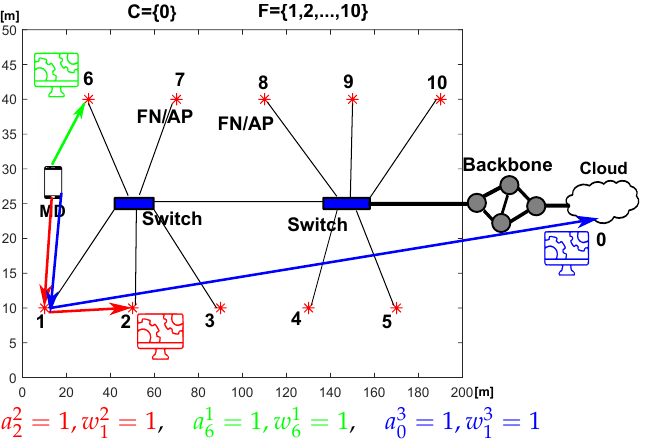
Figure 2. Diagram of the considered network composed of 10 FNs and a cloud with three examples of request